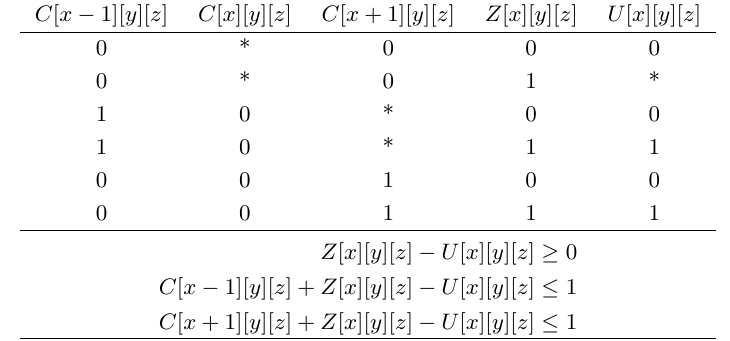
Table 4: Patterns of key bits and cube variables. Symbol ‘*’ denotes arbitrary